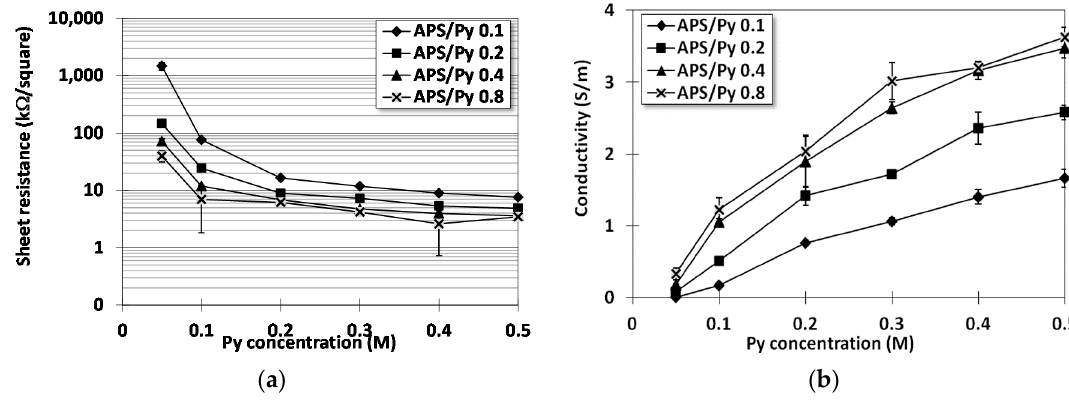
Figure 3. The electrical resistance of PPy films: ( a ) the sheet resistance; and ( b ) the conductivity (reciprocal of sheet resistance × film thickness).